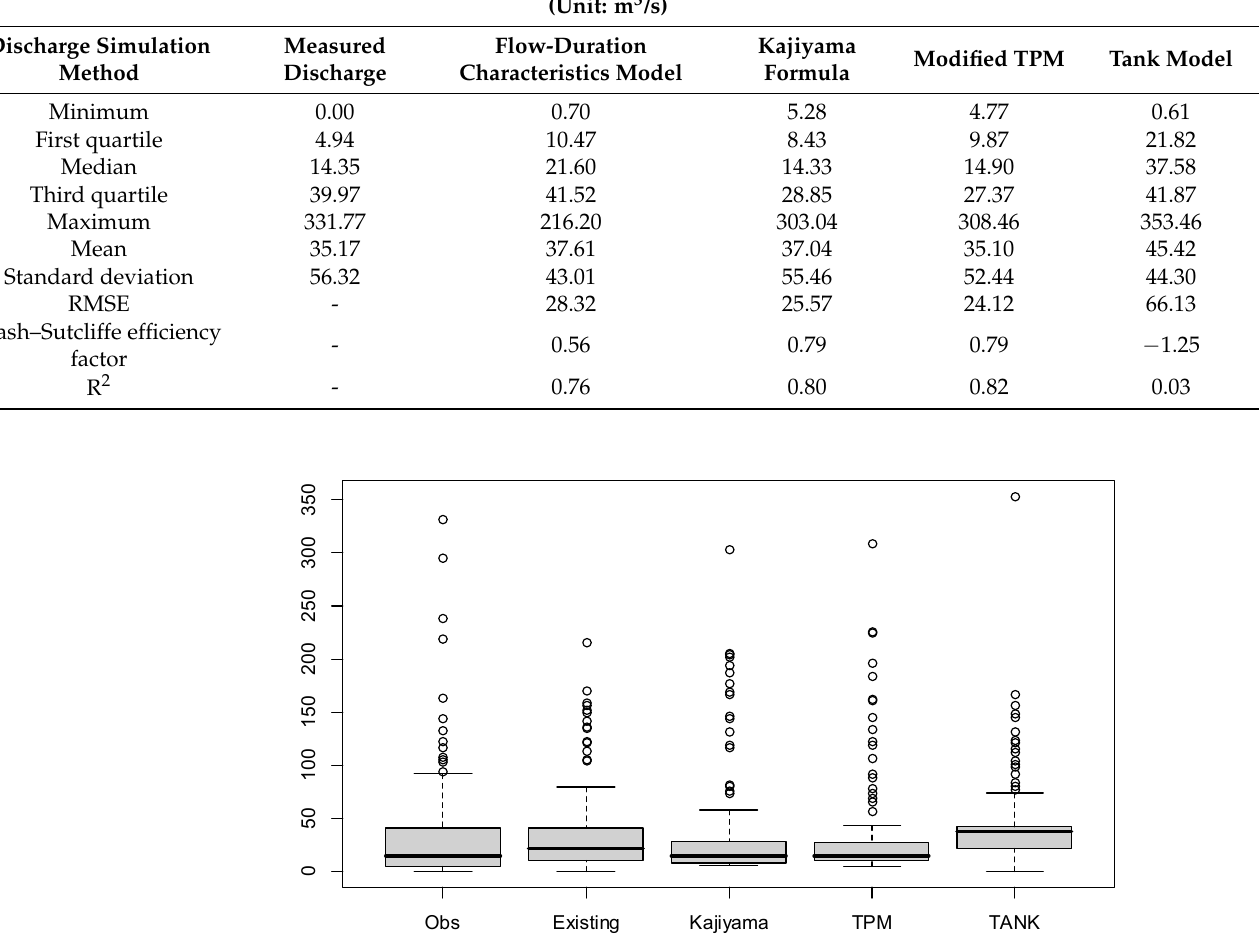
Figure 2. The distributions of the simulated and measured monthly average discharge by the simulation method for the Deoksong SHP plant (unit: m 3 /s).